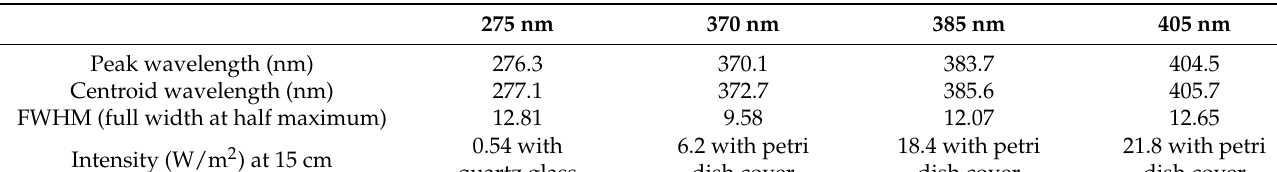
Figure 2. Specifications of the LED modules used in this study. ( a ) Spectra and intensities of the LED modules by wavelength. ( b ) The measurement points of LED module intensity. Table 2. Specifications of the UV-C, near-UV, and visible light LED modules.